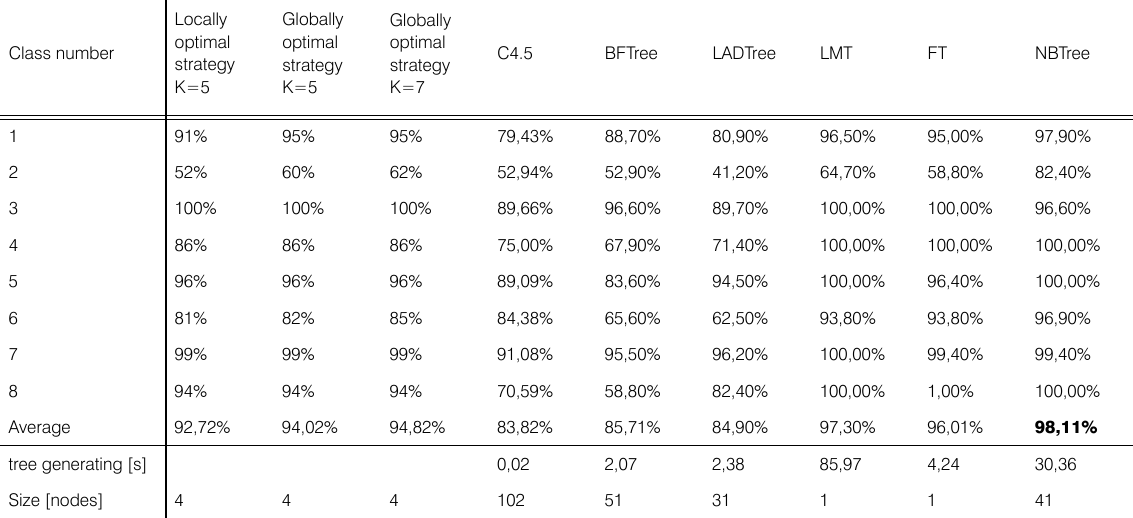
Table 1. Frequencies of correct classifications, tree generating time and size of